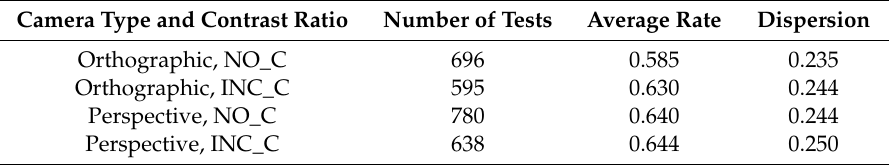
Table A10. Numerical results of the users regarding the camera type and contrast ratio.